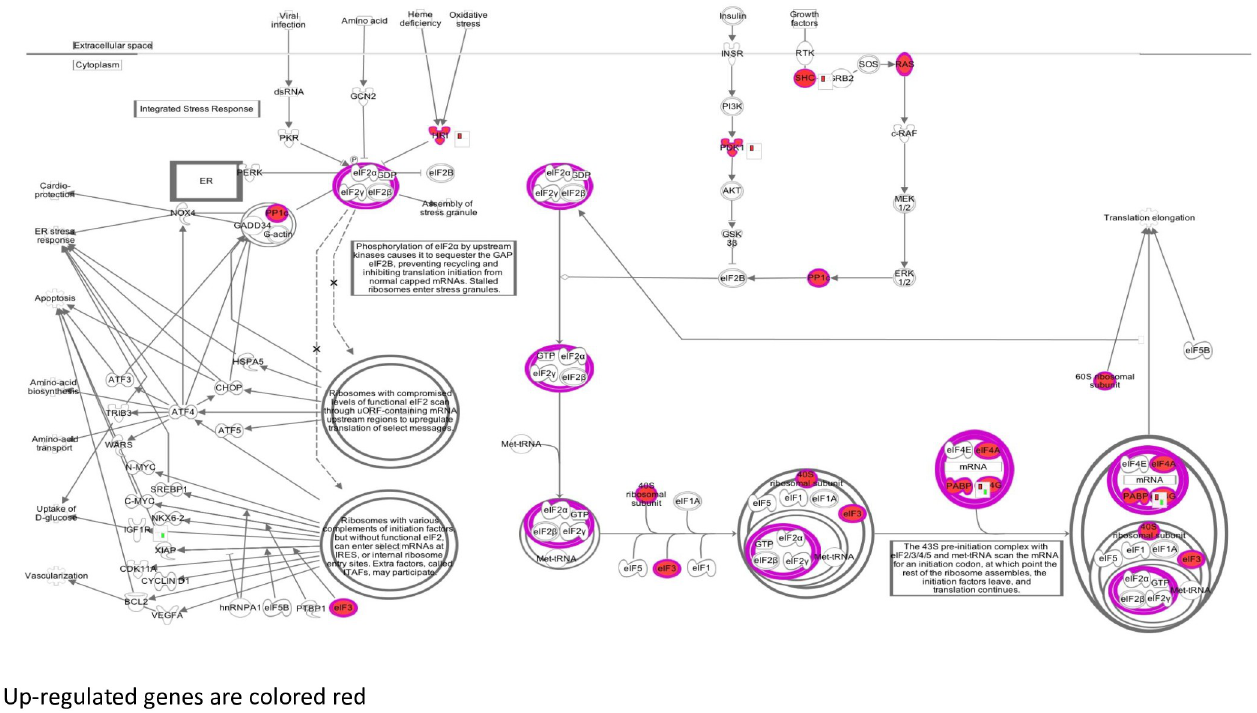
Fig 5. EIF2 signaling pathway: Male 2-year turquoise module. Red fill indicates genes positively correlated with lesion burden.